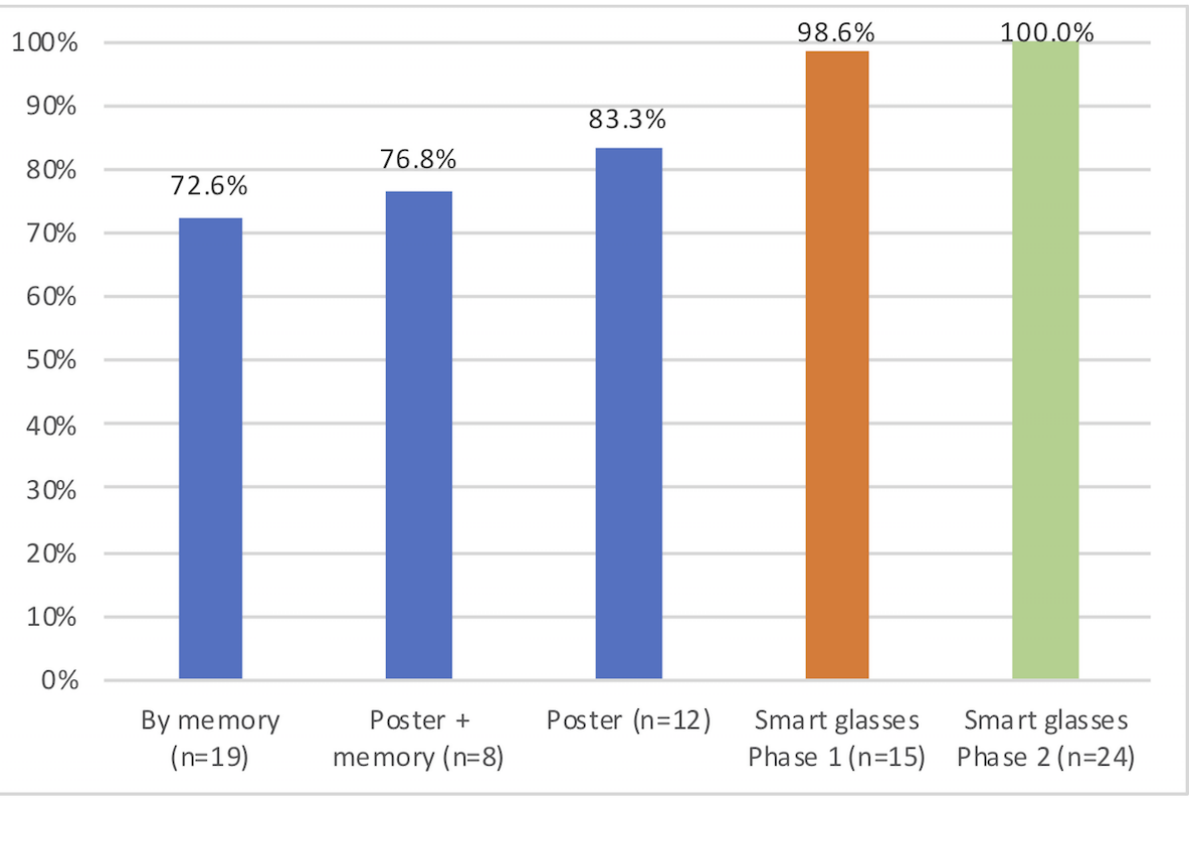
Figure 3. Completion rates across all mediums.